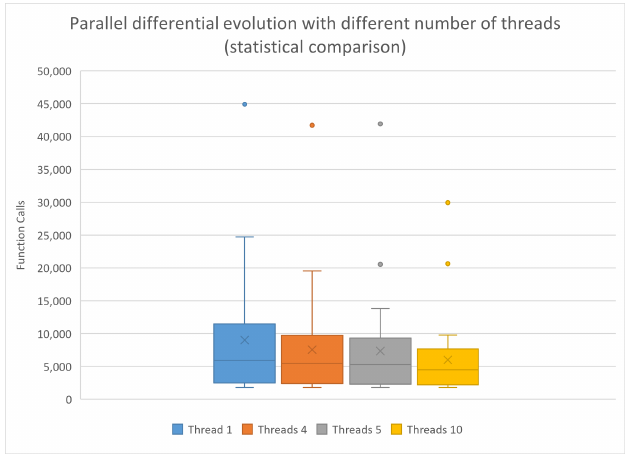
Figure 2. Statistical comparison for the proposed method and different numbers of threads.